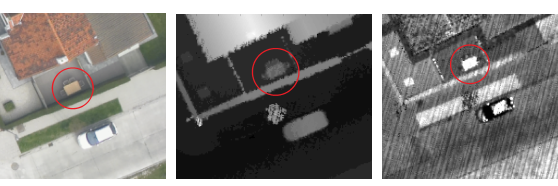
Figure 17. Misclassification of an object similar to a car. The left RGB image shows garden furniture which was falsely classified as a car. In the elevation image in the middle and the intensity image on the right the furniture has the same type of edges like a car roof which may have led to the misclassification.